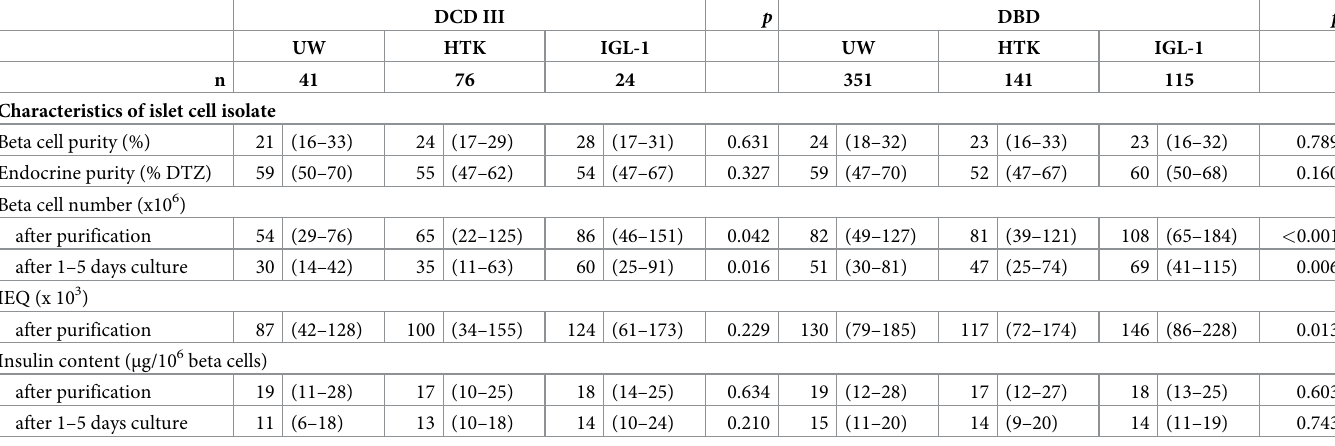
Table 5. Effect of cold preservation solution type on beta cell